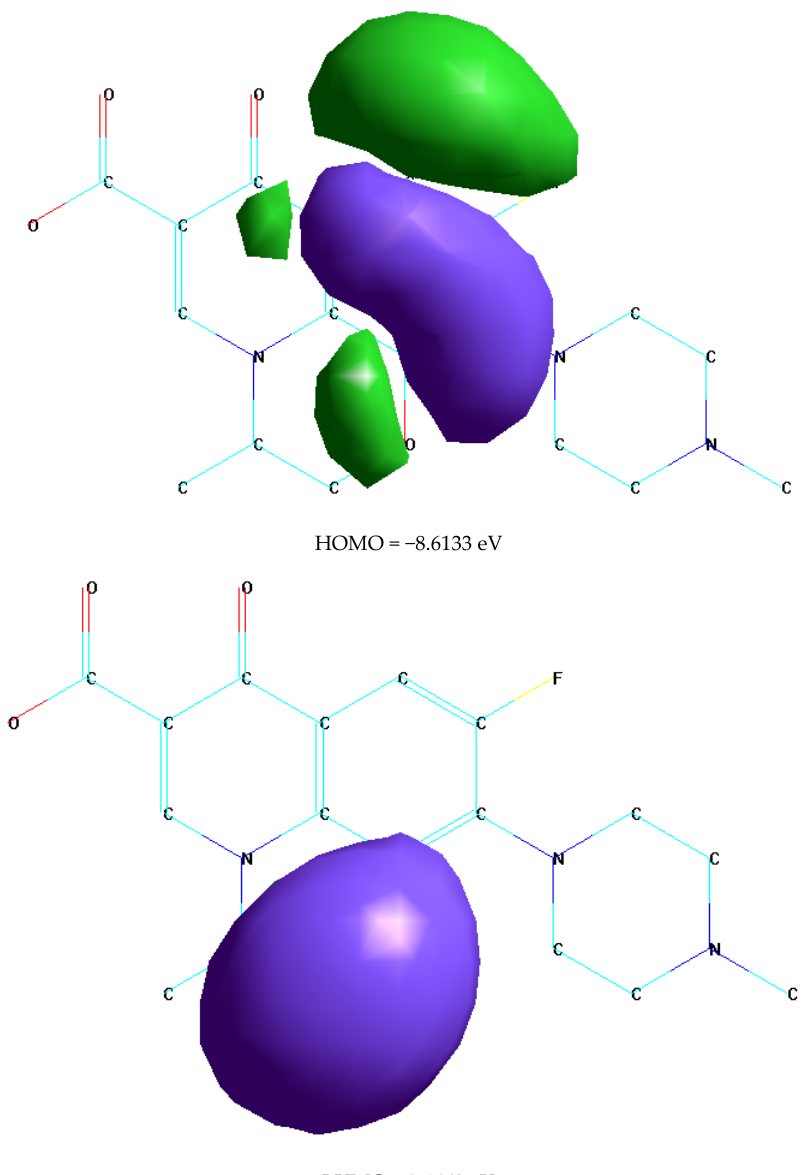
Figure 10. HOMO and LUMO structure of free OFL